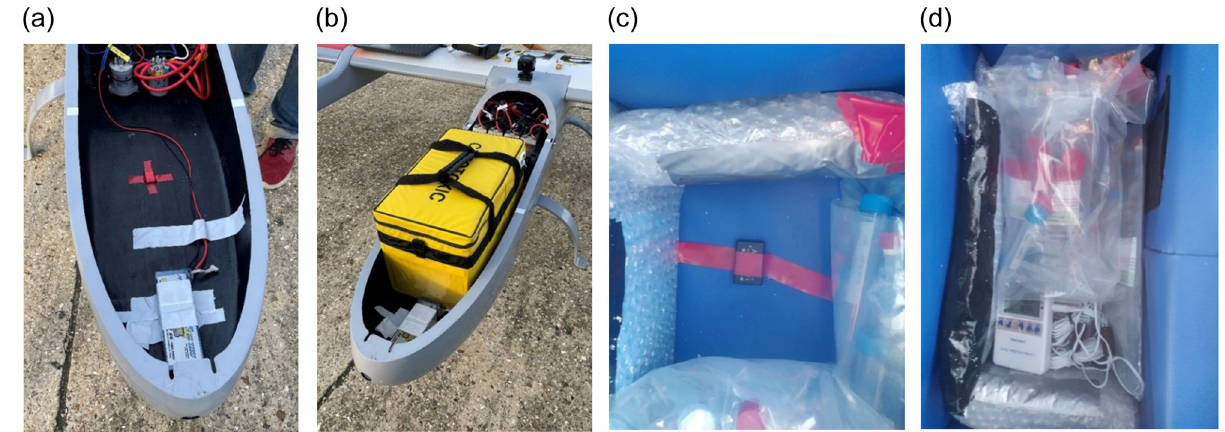
Fig 3. (a) Cargo bay with base vibration sensor mounted (held in position by red tape); (b) Loaded 18 L Versapak; (c) Versapak base sensor; (d) Versapak with insulated cool packs, sensors,